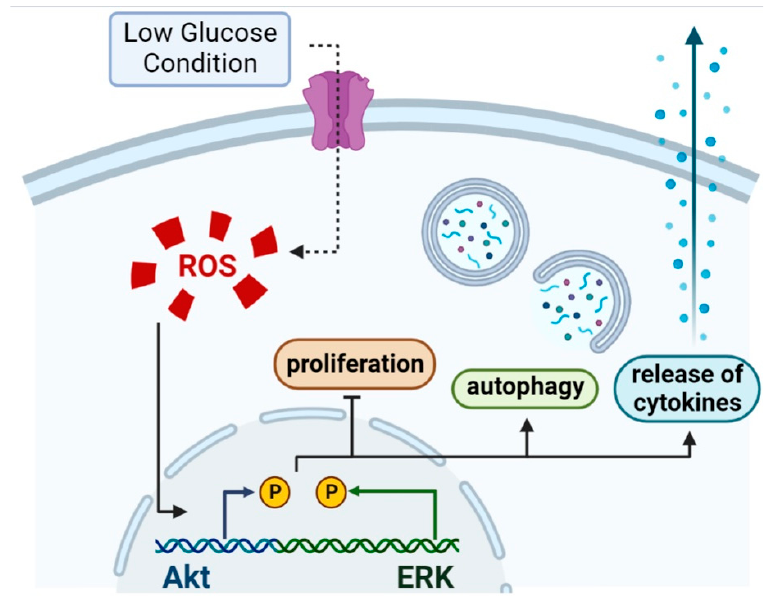
Figure 7. The low glucose environment could increase ROS accumulation. Increased ROS allows for phosphorylation of the Akt signal pathway and ERK pathway, which inhibits cell proliferation, induces cellular autophagy, and increases the expression of inflammatory cytokine.